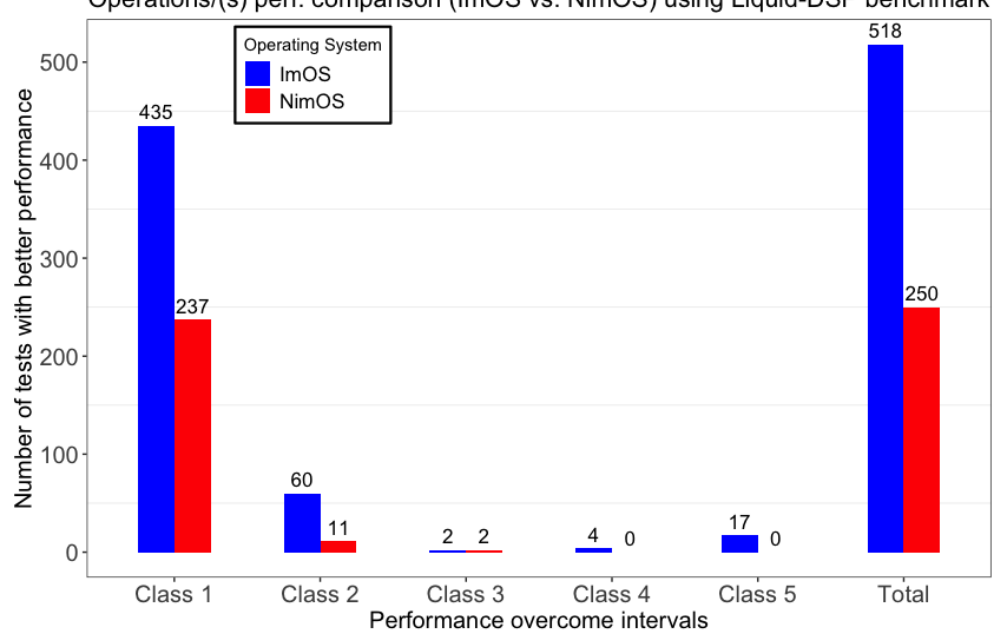
Figure 12. ImOS vs. NimOS: Number of tests in which an OS overcame the other one. Classes defined in Table 8 identify improvement percentage obtained by the faster